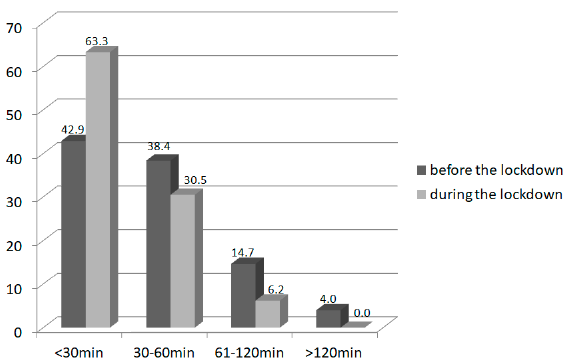
Figure 2. The amount of high physical activity (in minutes per day) in children (n = 177) before and during the lockdown.